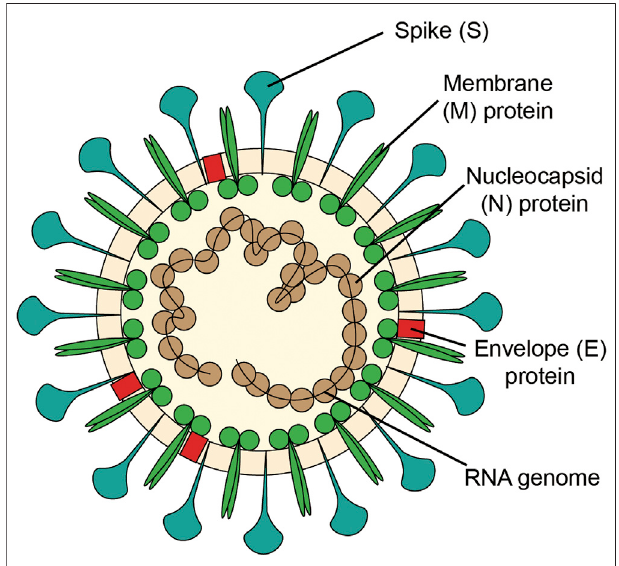
FIGURE 1 | A vision of coronavirus with the minimal set of structural